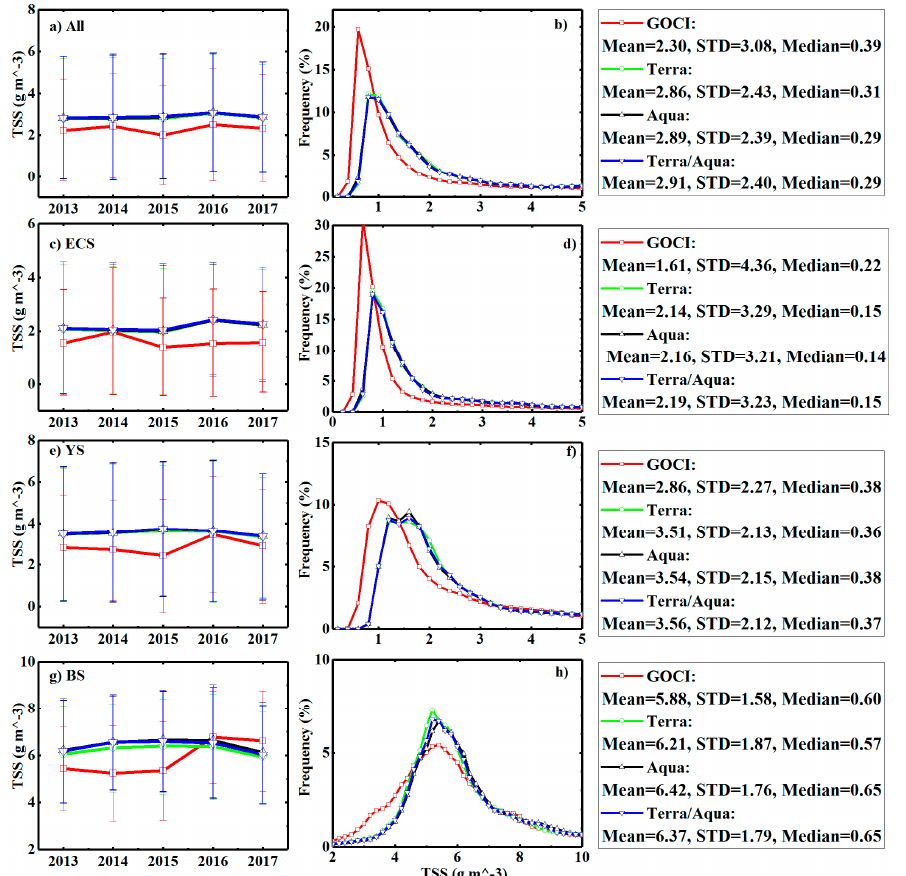
Figure 17. Annual trends and histograms of TSS ( a , c , e , g ) in China’s seas from different sampling frequency ( b , d , f , h ) observations from 2013 to 2017.